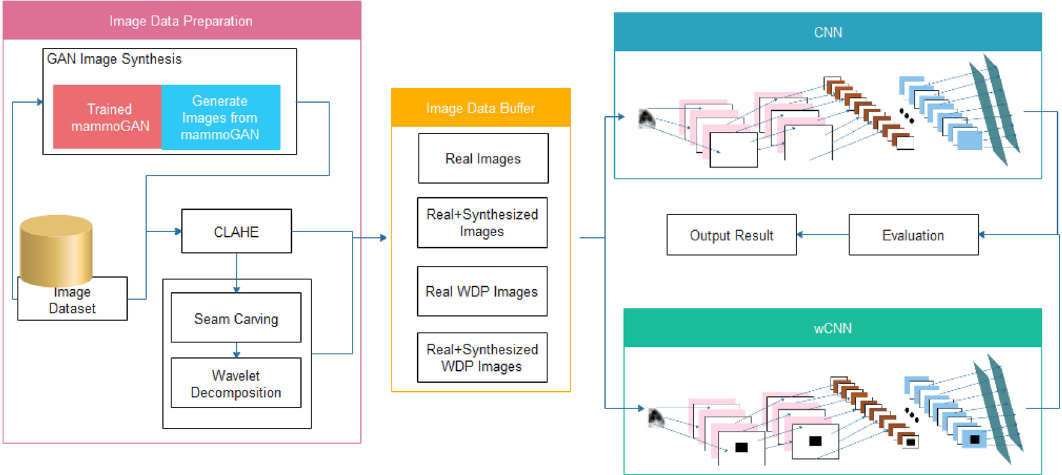
Figure 1. Block diagram describing the overview of the approach used in this study, which consists of image preprocessing, GAN-based augmentation, seam carving, wavelet decomposition, and wavelet convolution (CNN and wCNN)